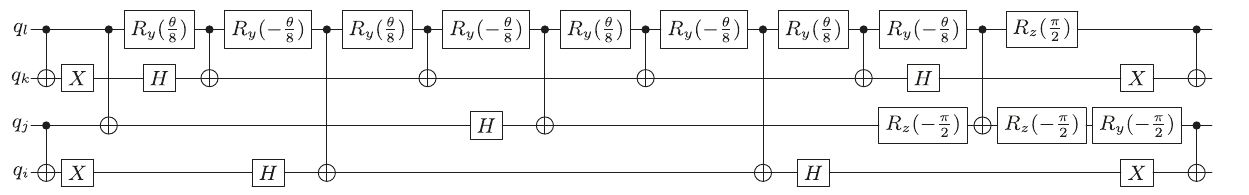
Fig. 2 A circuit to implement a double-qubit-excitation evolution. A double-qubit-excitation evolution is de fi ned by the unitary operator ~